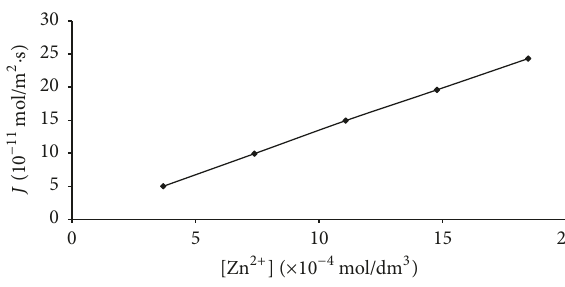
Figure 4: Effect of HCl concentration in feed solution on flux ( 𝐽 ) of Zn (II). [HCl] in feed solution = 0.50 mol/dm 3 to 3.0 mol/dm 3 , [TDDA] in membrane phase = 0.80 mol/dm 3 , [NaOH] in stripping solution = 2.0 mol/dm 3 , time = 5.0 h.